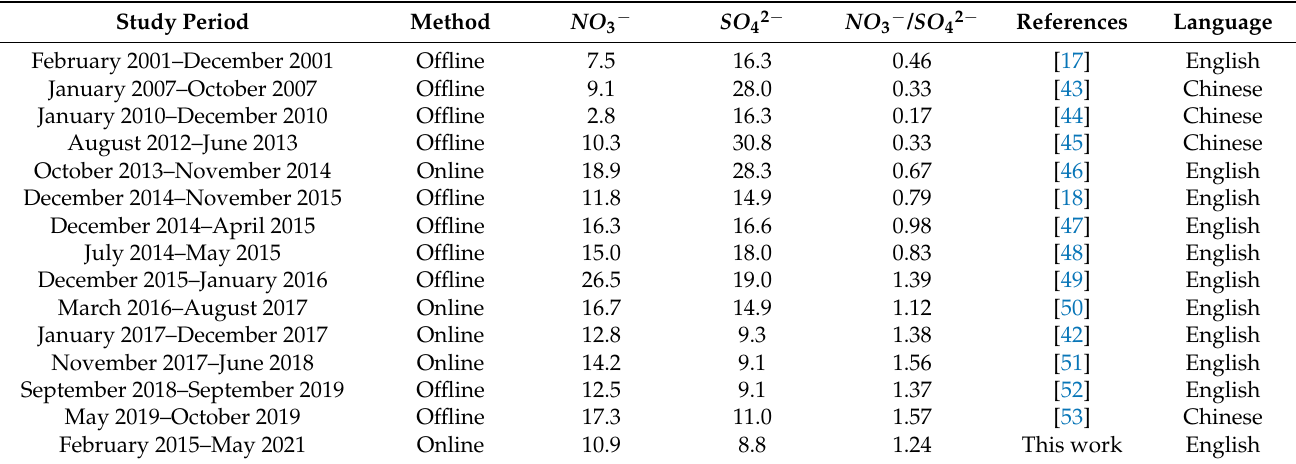
Table 2. Concentrations of NO 3 − and SO 42 − and values of NO 3 − to SO 42 − in PM 2.5 measured by different research at Nanjing ( µ g · m − 3